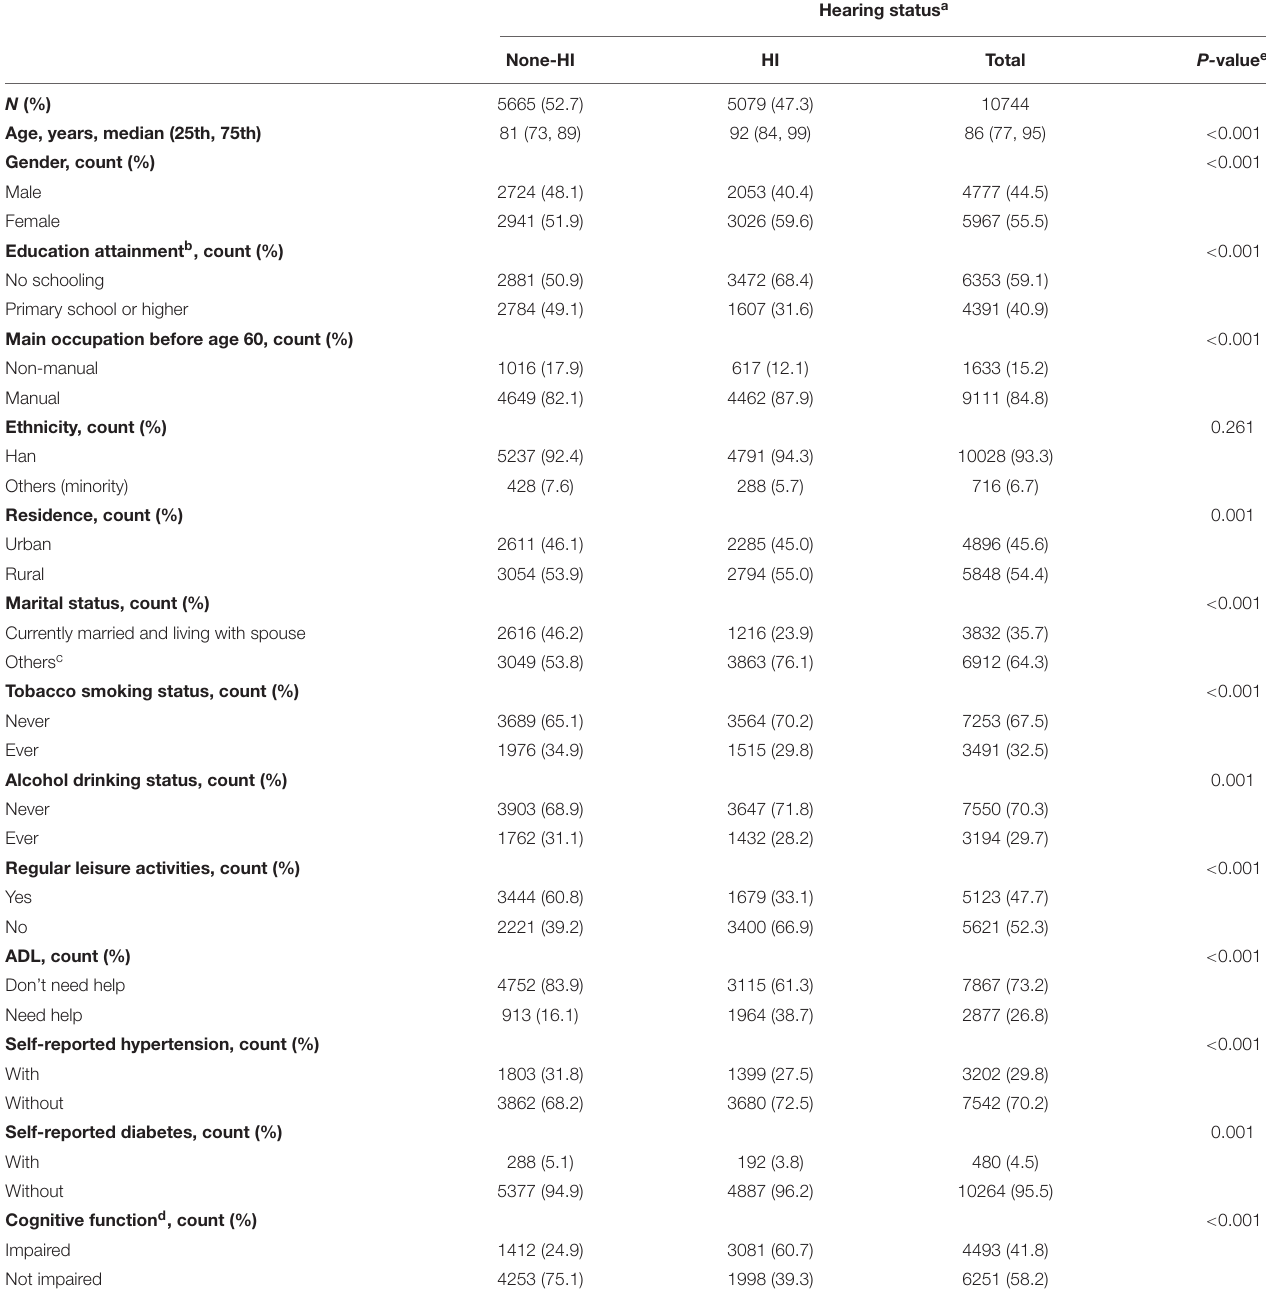
TABLE 1 | Baseline characteristics by hearing status among Chinese aged ≥ 65